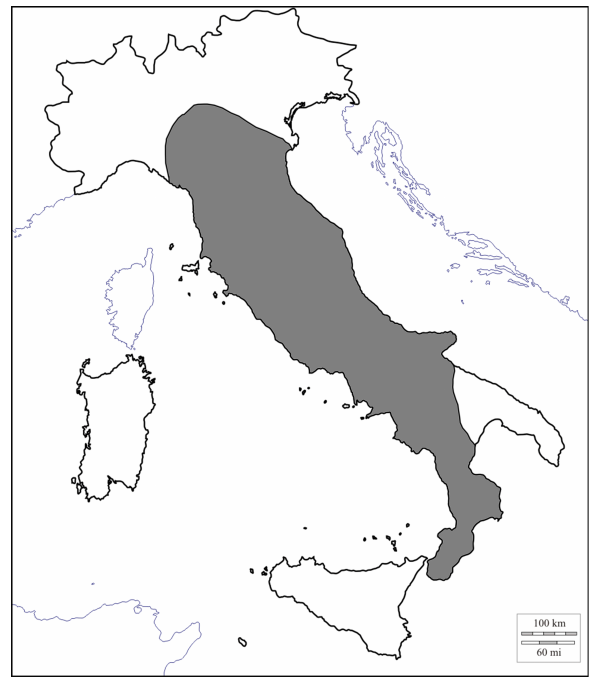
Figure 6. Distribution map of Sorex samniticus (redrawn from Nappi and Aloise